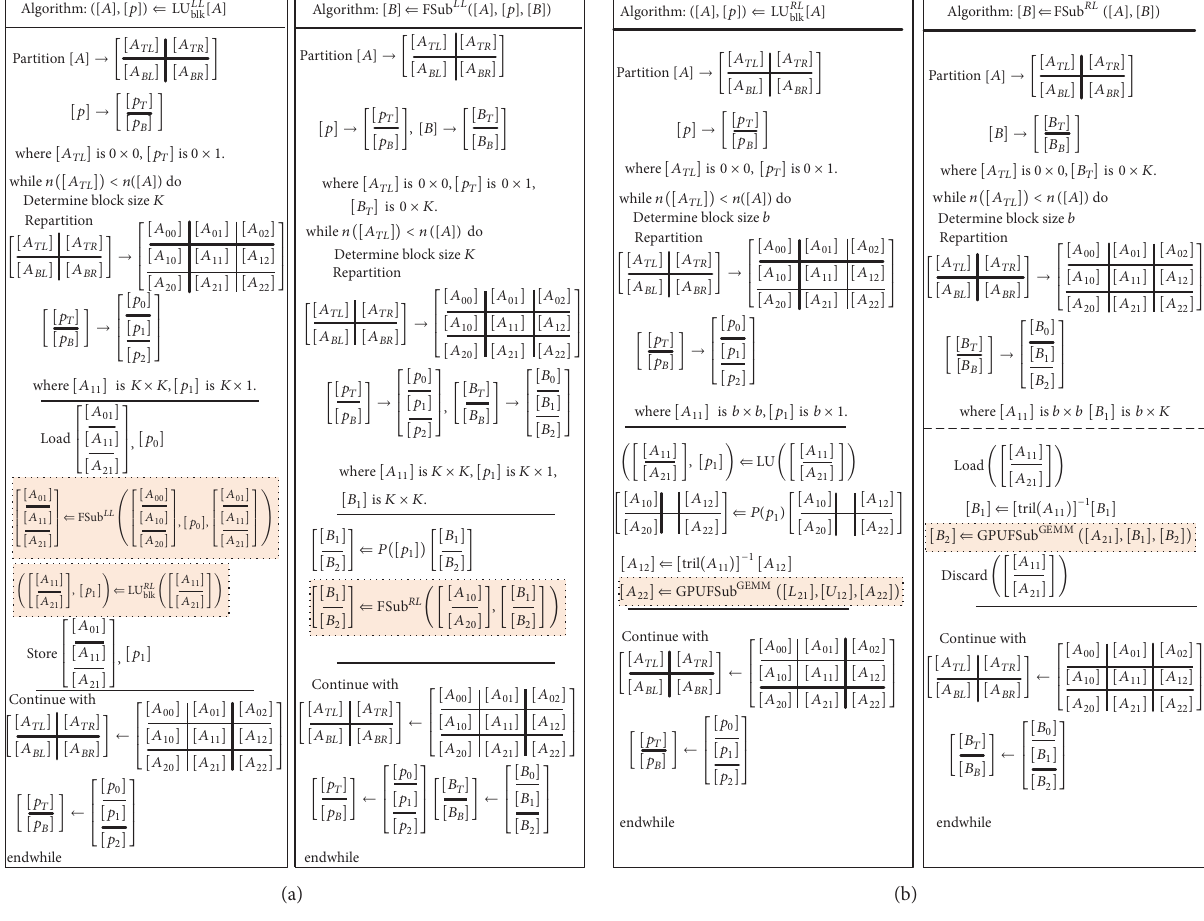
Figure 10: The scheme of the GPU-based out-of-core LU